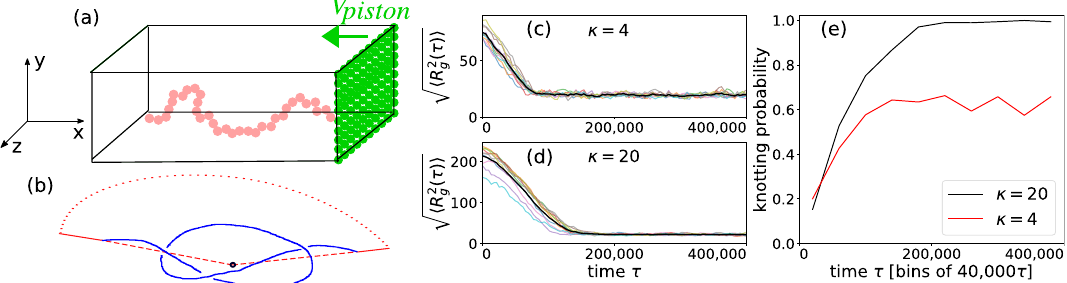
Figure 3. Schematics of the simulation model. ( a ) A semi-flexible bead-spring chain confined inside a rectangular nano-channel is pushed by the green piston from right to left at velocity v = v piston . The confinement potentials are imposed on four (two xy and two xz ) planes, and by the moving piston in the yz plane in the negative x direction. The chain is free to move on the side opposite the piston. This figure was created using Xfig (version 3.2.8a, URL: https:// sourc eforge. net/ proje cts/ mcj/). ( b ) Demonstration of the knot closure. The termini of the polymer are connected with the center of mass (black dot) as indicated by the dashed red lines. The solid red lines are then appended to the polymer and connected by a closing arc drawn with red dots. ( c , d ) The root-mean-squared radius of gyration (cid:31) (cid:31) R 2 g (τ) (cid:30) of the polymer as a function of LD time τ for 10 simulations each and two different values of the chain stiffness, κ = 4 and 20, respectively. The polymer is compressed until it reaches a steady state with a constant radius of gyration. At this point it moves like a blob of a fixed shape. The steady state (cid:31) (cid:31) R 2 g (cid:30) for the polymer with lower stiffness is significantly smaller in its final state. ( e ) The knotting probability as a function of time τ . During compression, the knotting probability increases while it is constant in the steady state. A higher stiffness leads to a higher knotting probability in the steady state. The results are averaged over 20 independent runs